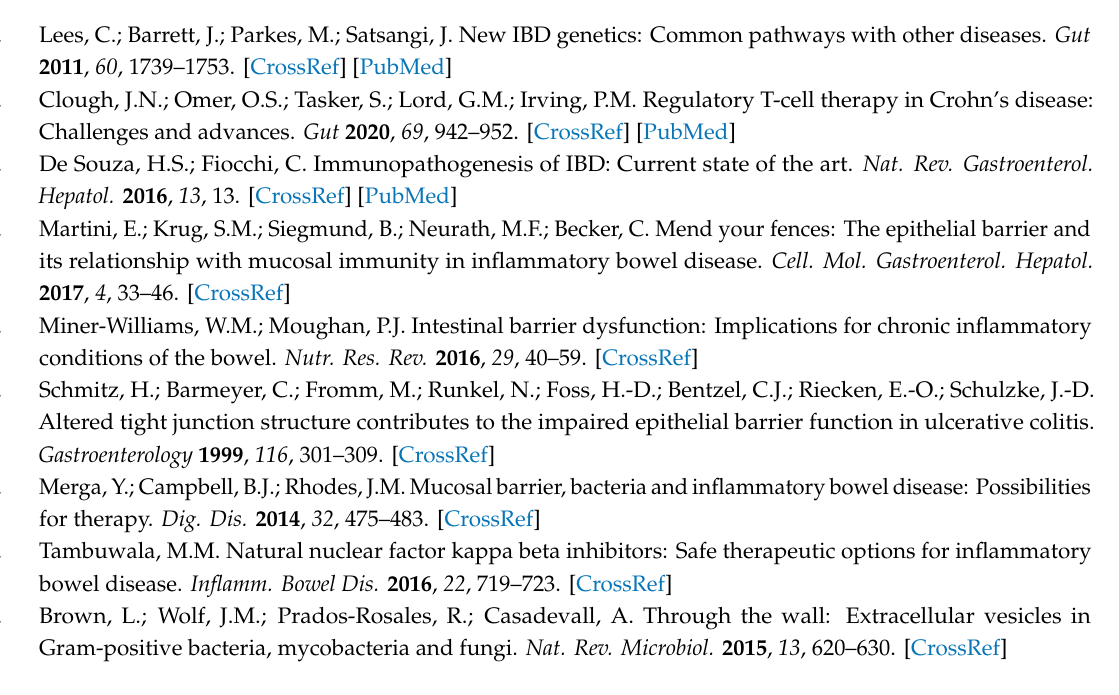
Table S1: List of RT-PCR primers used in this